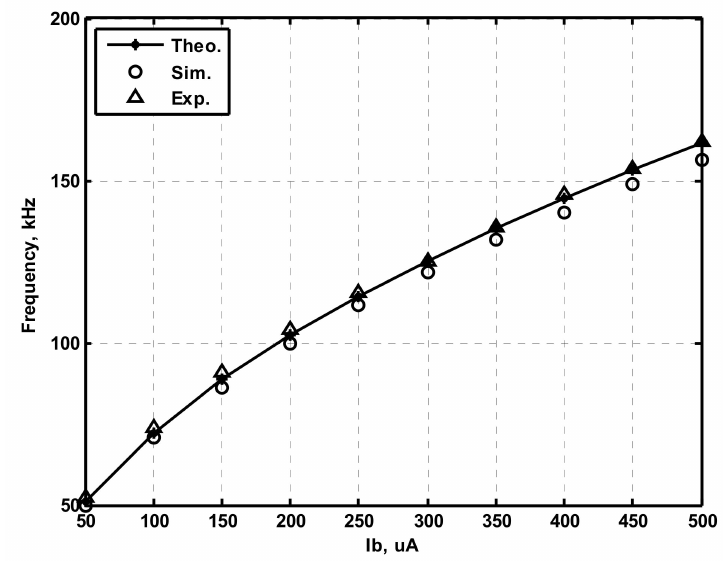
Figure 25. Results of the FO by varying g m3 .